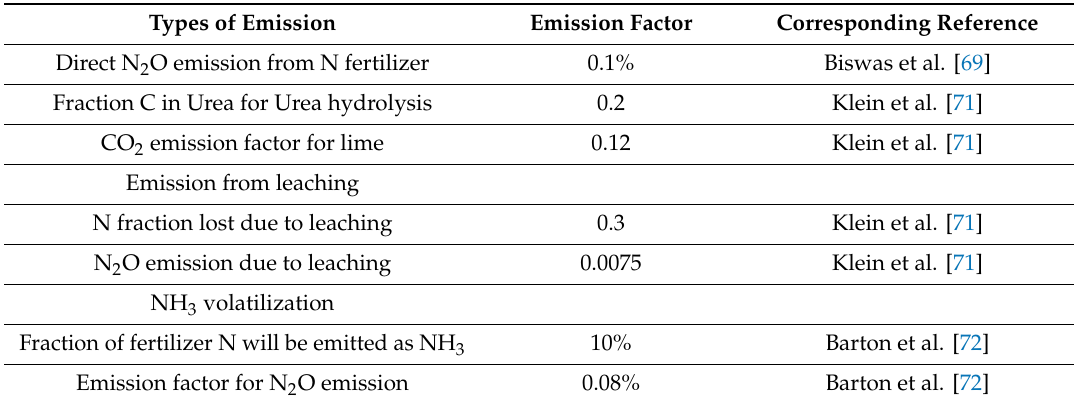
Table 5. Emission factor used for soil emission.